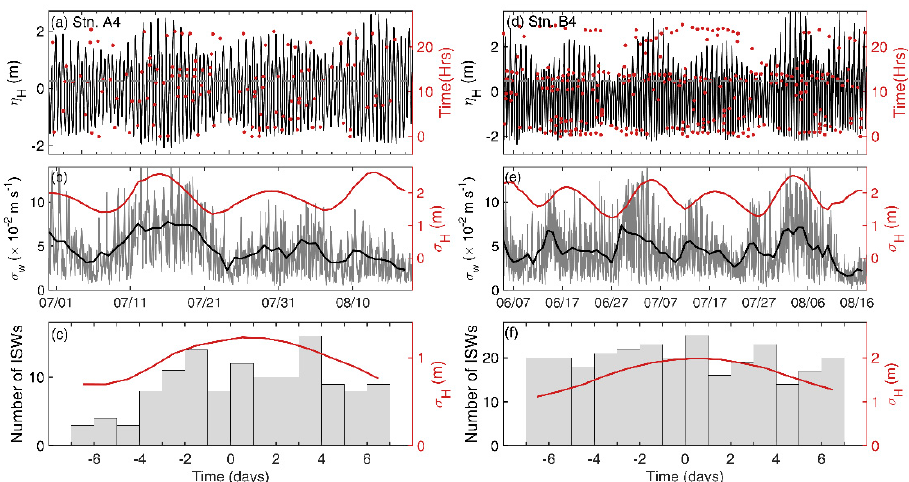
Figure 7. Statistical characteristics of ISWs. ( a , d ) The temporal variation of surface elevation (black line) and occurrence of ISWs (red points) relative to the time of low tide. ( b , e ) RMS vertical velocity in one–hour (grey curves) and one–day intervals (black curves). The red curve represents the 1.8 × RMS variations of the sea surface. ( c , f ) The number of observed ISWs during a fortnightly cycle, binned by days before/after the time of maximum tidal range.